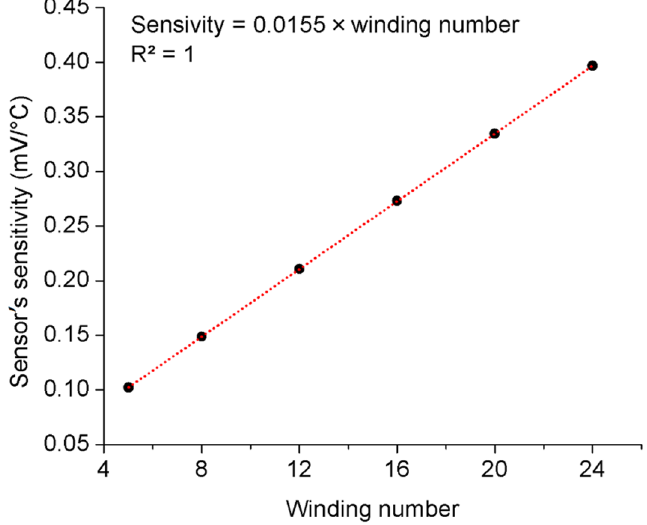
Figure 4. Comparative study of the sensor’s sensitivities from the simulations results.